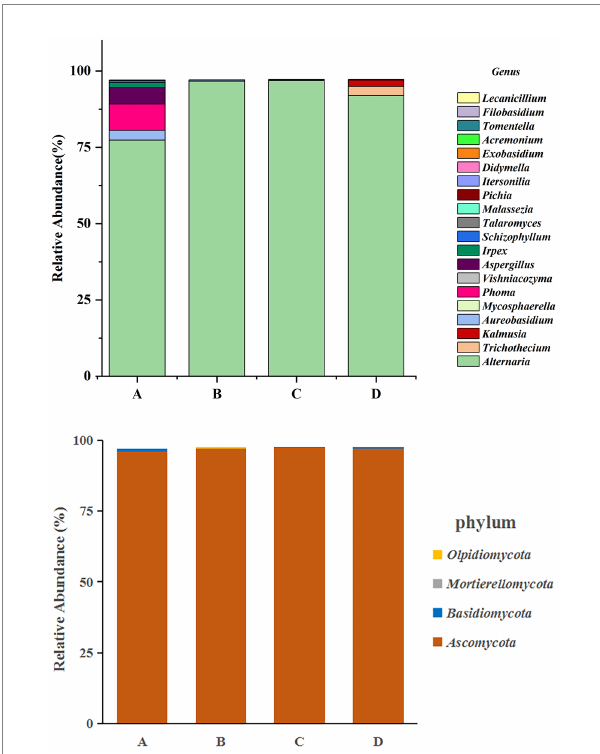
FIGURE 3 Analysis of fungal community diversity at the phylum level and genus level of Yuluxiang pears stored at low temperature for 30 d(A), 60 d(B), 90 d(C), 120 d(D), and different colored dots indicated different samples